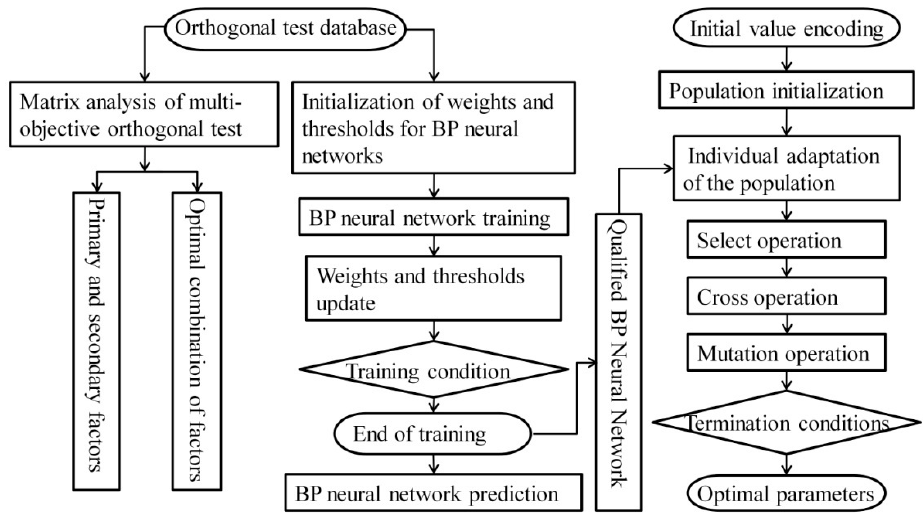
Figure 6. Scheme flow of concurrent design for multi-variable multi-objective.